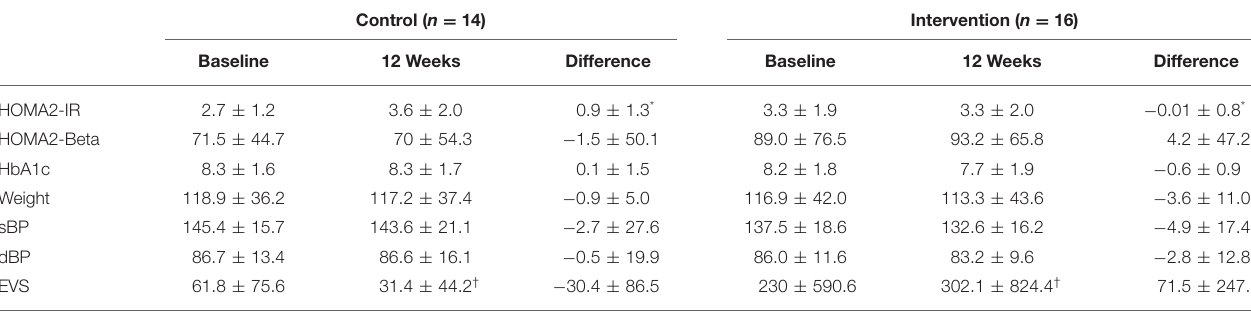
TABLE 2 | Baseline, 12-week follow-up, and difference in primary and secondary outcomes in the control and intervention groups. Control ( n = 14) Intervention ( n = 16) Baseline 12 Weeks Difference Baseline